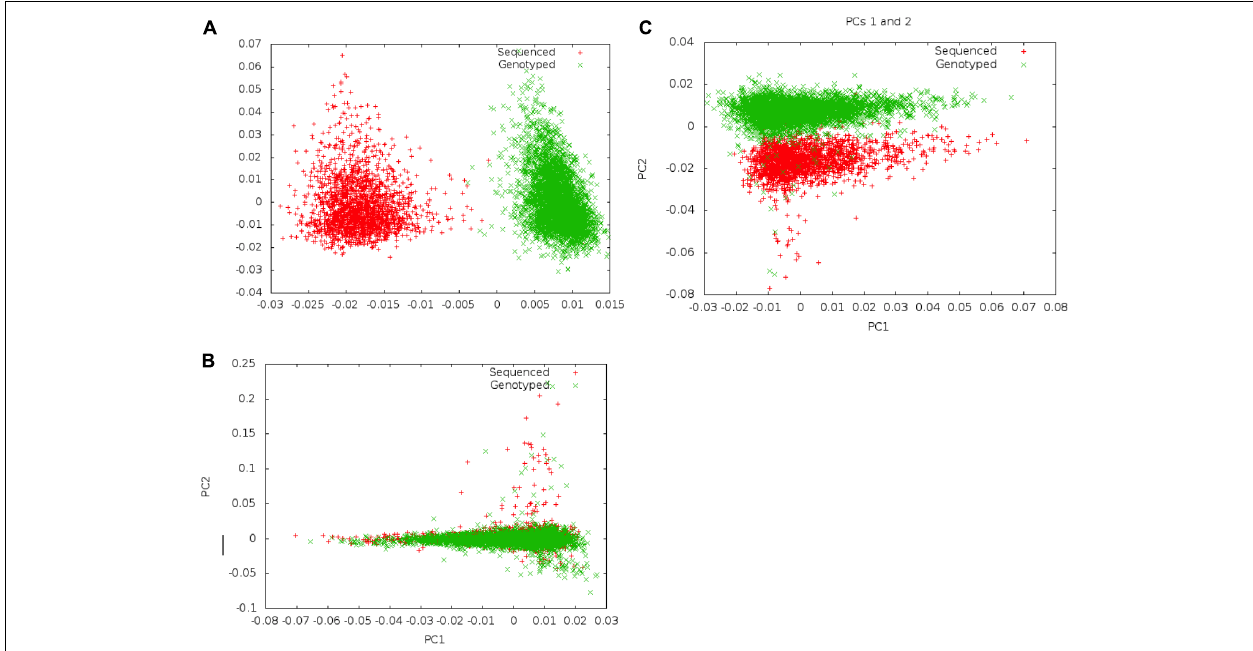
FIGURE 2 | Separation on PCA between genotype and Sequence data using different filters. Panel (A) shows separation of sequenced and imputed genotyped samples in pooled PCA analysis of 6,407 individuals from UGR along PC 1. On filtering of variants that showed < 80% concordance between sequenced and genotype data in a set of 343 individuals who were genotyped and sequenced, this separation was reduced, and became a secondary axis of variation (along PC 2) (B) . Panel (C) shows that separation along PCs 1 and 2 is removed on filtering variants with concordance < 90% between sequenced and genotyped